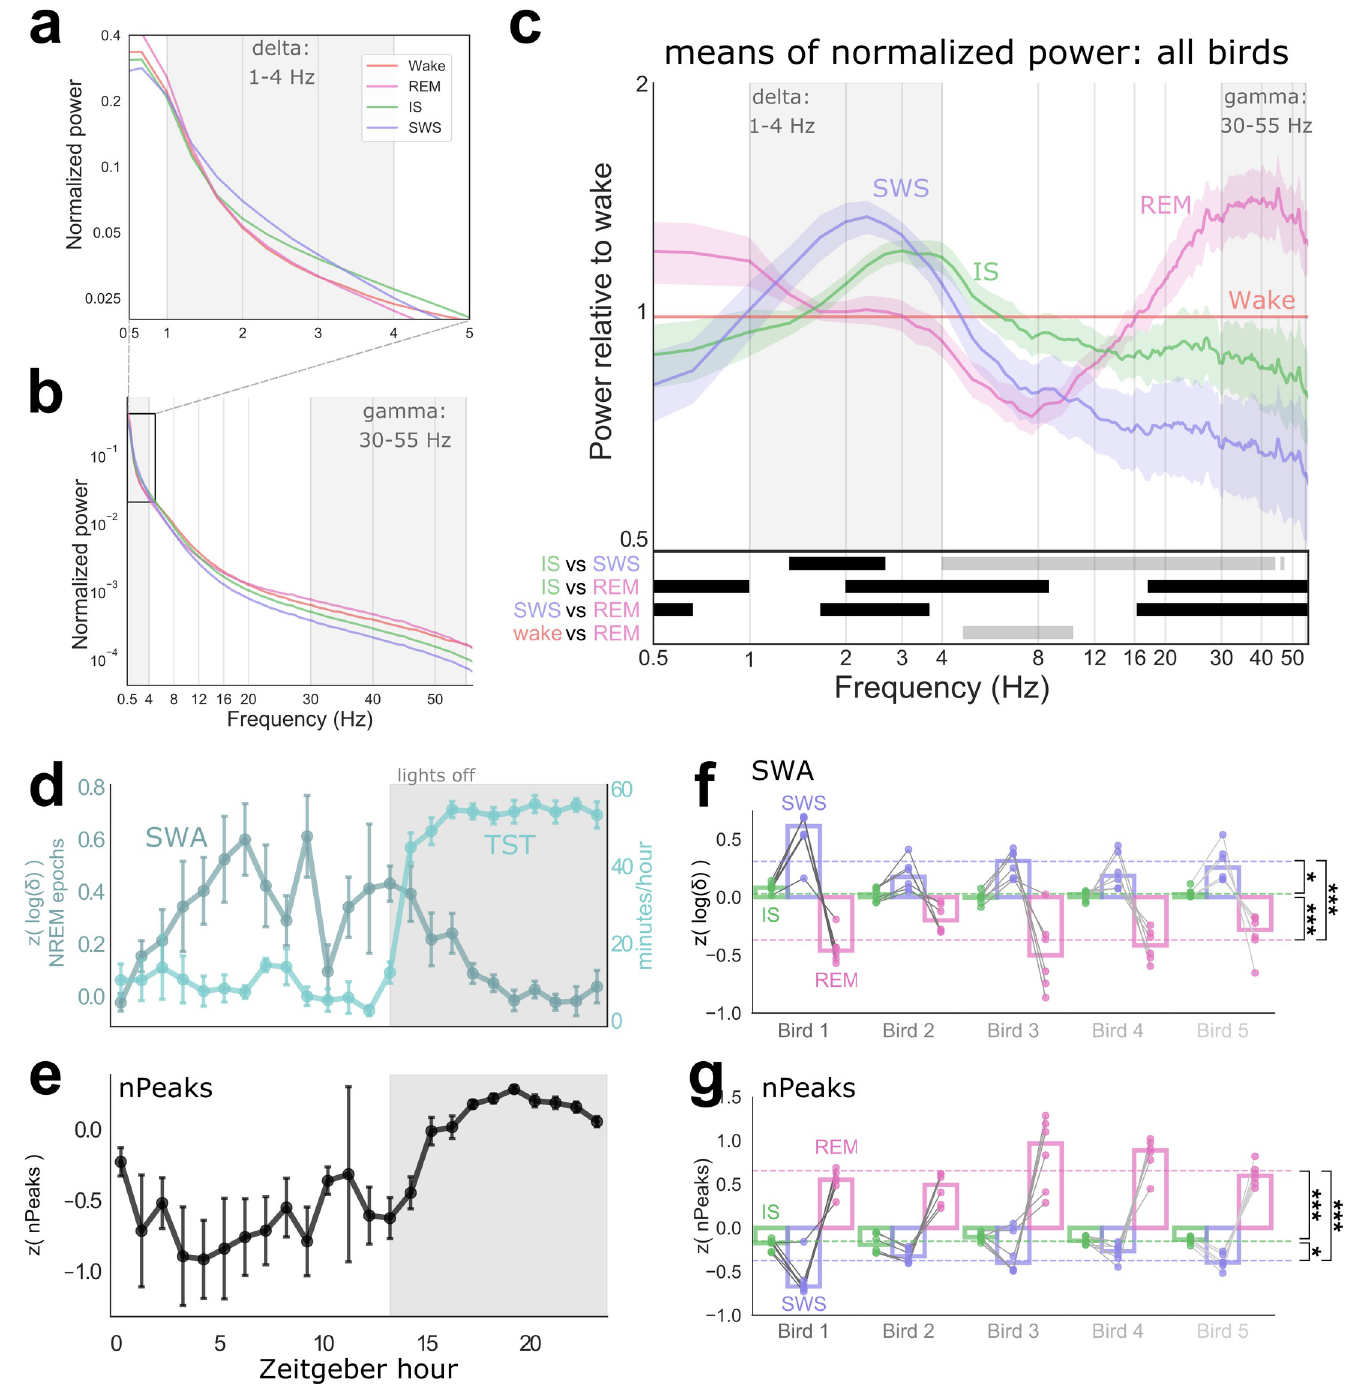
Fig 4. Spectral characteristics of sleep states. Average of normalized power spectra of all birds highlighting delta (a) and gamma (b) bands. (c) Top, the 3 major sleep states (averaged normalized power spectra from all birds) plotted relative to Wake (i.e., divided by Wake spectrum). Shading around each line indicates SEMs. Gray boxes highlight delta and gamma frequency bands. SWS had a significant peak in the delta band, while REM peaked in the gamma band. Bottom, statistical comparisons between pairs of normalized spectra (i.e., before spectra were divided by Wake). Black indicates significant differences (Ru¨ger’s areas; see text); gray indicates trends (consecutive bins with p < 0.05). (d–e) Sleep characteristics by hour, across the 24-h period. Shaded area indicates lights off. Error bars, SEM. (d) Dark blue (left y-axis), z-scored SWA (or delta content; see text) of NREM epochs. Light blue (right y-axis), TST per hour. SWA decreases across periods of higher TST. (e) The nPeaks (z-scored) of all sleep epochs. At night, nPeaks increased concomitant with the amount of REM. (f–g) Characteristics of sleep stages across birds. For each bird, all 6 EEG channels are shown as dots. Bars indicate the median across channels. Dashed lines, means across all birds. Paired t tests: � p < 0.05, ��� p < 0.005. (f)